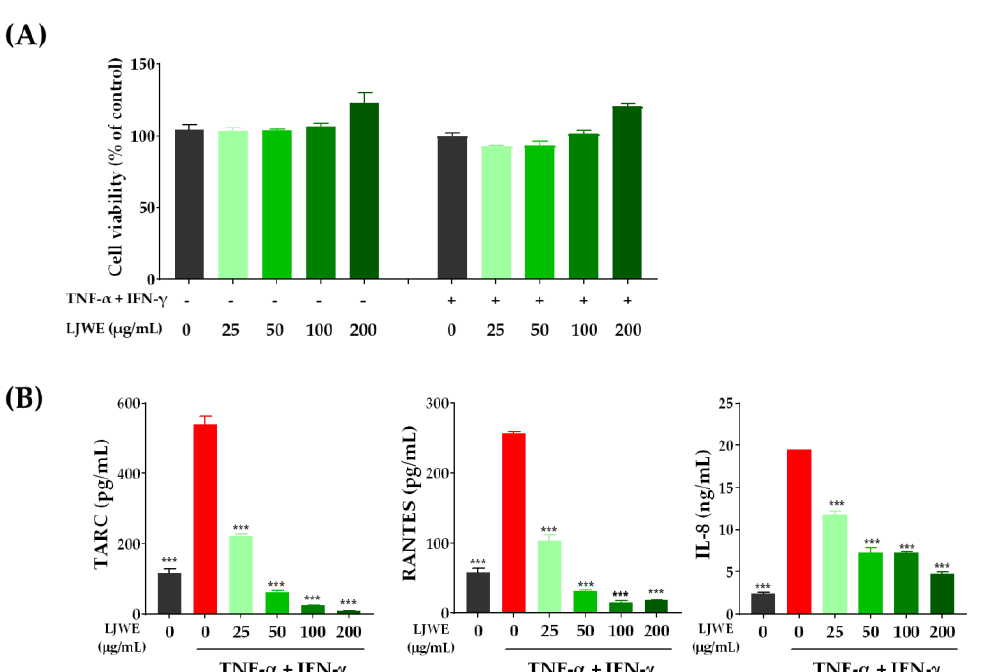
Figure 1. Laminaria japonica water extract (LJWE) inhibits the expression of inflammatory chemokines in tumor necrosis factor (TNF)-α/interferon (IFN)-γ-stimulated HaCaT cells. ( A ) Cell viability in the presence of LJWE. The cells were treated with 0–200 μg/mL of LJWE with (+) or without (−) TNF-α/IFN-γ-stimulation for 24 h, and the cell viability was measured using the Cell Counting Kit-8 assay. ( B ) The inhibitory effects of LJWE on the overproduction of interleukin (IL)-8, regulated on activation normal T-cell expressed and secreted (RANTES), and thymus and activation-regulated chemokine (TARC). *** p < 0.001 vs. control treated with vehicle.